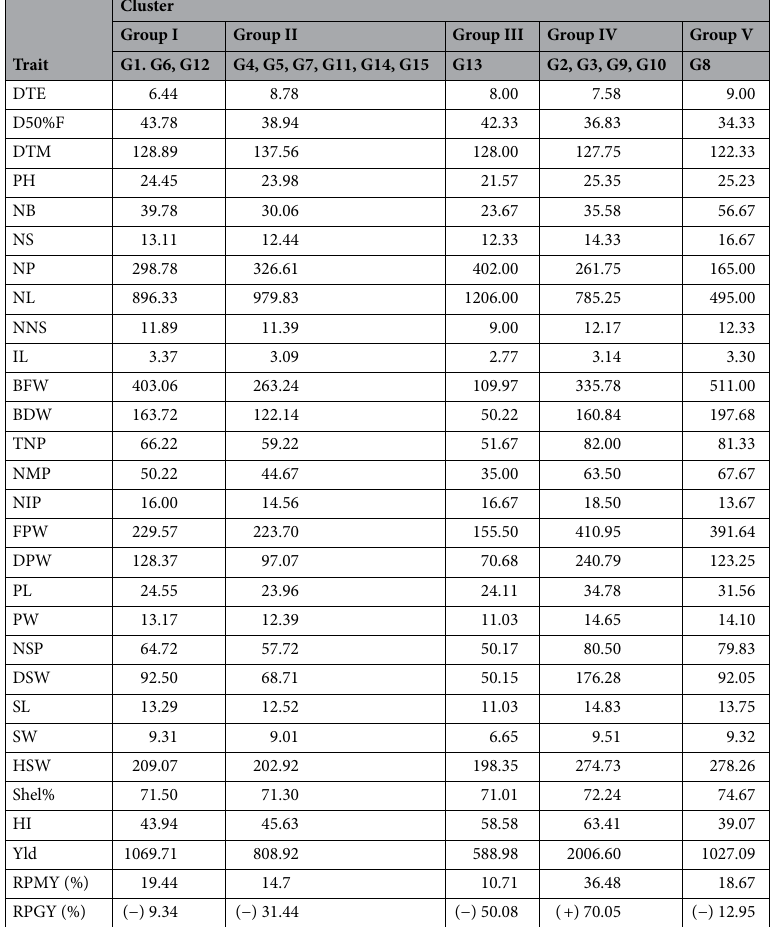
Table 8. Mean values of quantitative traits for 5 groups revealed by cluster analysis. RPMY relative proportion (%) of mean yield, grand average yield = 1180 kg ha −1 ; RPGY (%) relative proportion of grand average yield, ‘( +)’ = yield higher; ‘(−)’ = yield lower. DTE (day) days to emergence, D50%F (day) days to 50% flowering, DTM (day) days to maturity, PH plant height (cm), NB number of branches per plant, NS number of stems per plant, NP number of petioles per plant, NL number of leaves per plant, NNS no. of nodes per stem, IL (cm) inter nodes length, BFW(g) biomass fresh weight per plant, BDW(g) biomass dry weight per plant, TNP total no. of pods per plant, NMP number of mature pods per plant, NIP number of immature pods per plant, FPW(g) fresh pods weight, DPW(g) dry pods weight, PL(mm) pod length, PW (mm) PW, NSP number of seeds per